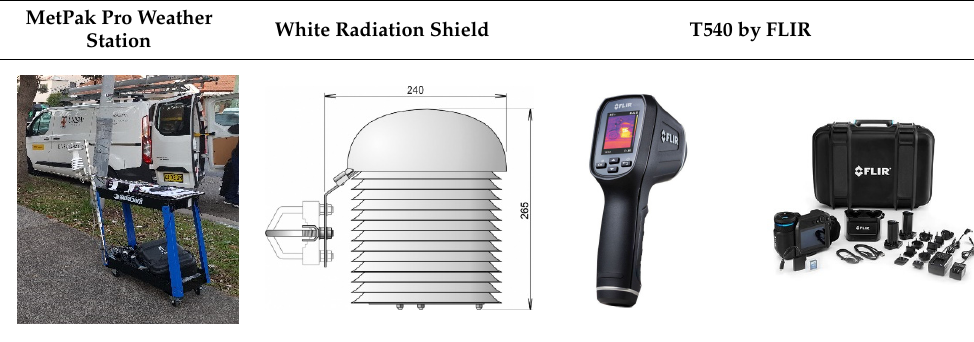
Table 7. Meteorological input for the simulation of scenarios on 17 January 2019.